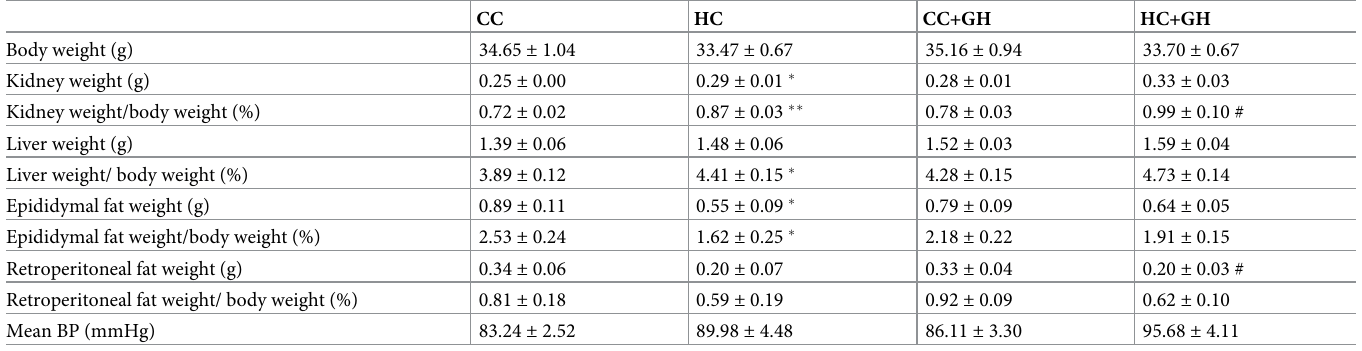
In offspring at postnatal week 9, similar levels of glucose tolerance were observed irrespective of maternal obesity or hydralazine administration during gestation (Table 4). Similarly, neither Table 3. Biometric parameters of week 32